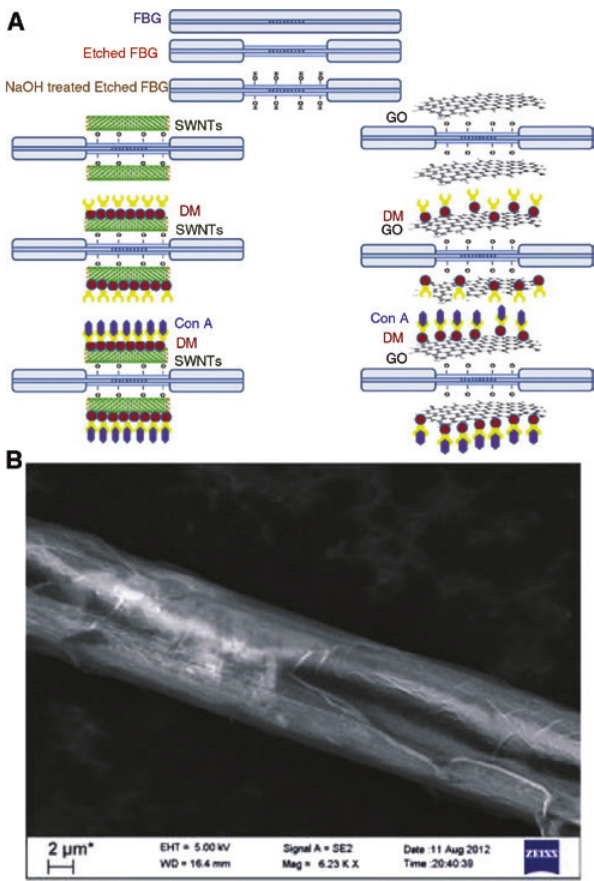
Figure 3: Flow chart of the manufacturing steps for coating an EFBG with GO and SWNTs (A) and a SEM image of the fiber coated with GO